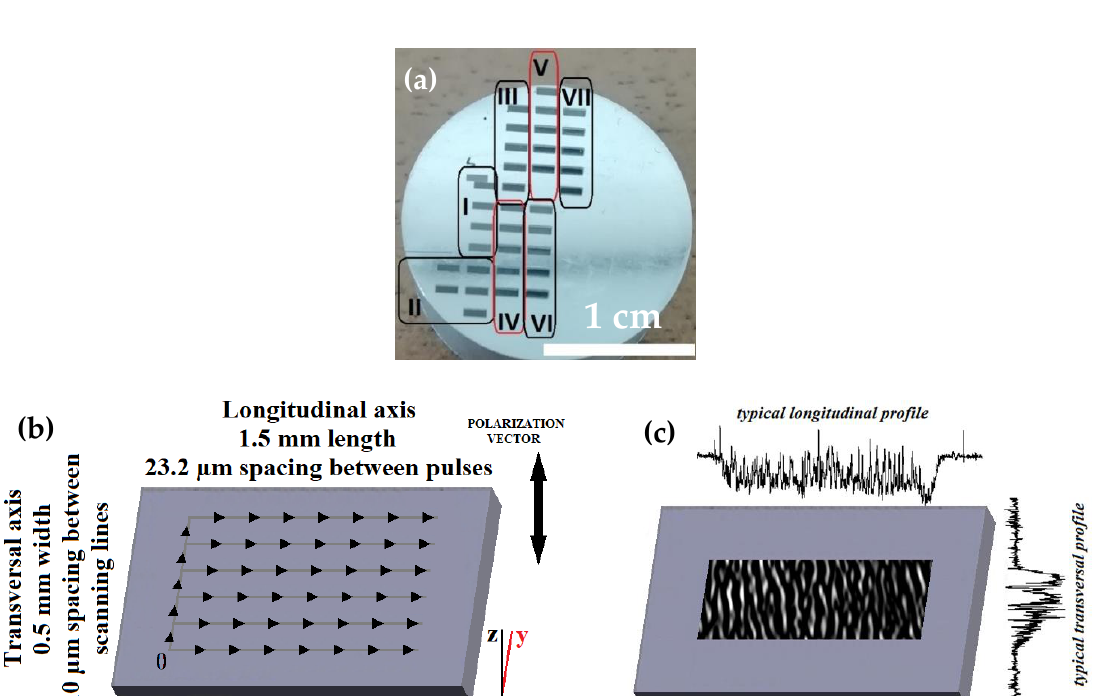
4 of 16 Table 2. Laser beam spot parameters for different treatment series. Treatment Series